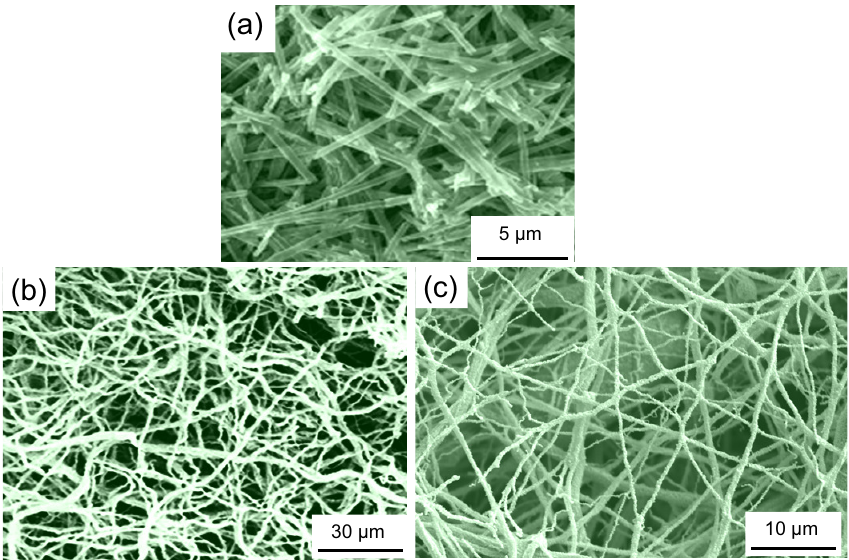
Figure 12. Comparison of HTSc nanowires fabricated using the AAO template approach (( a ), YBCO) [77] with such prepared by the electrospinning technique (( b ), Bi-2212) as measured in Ref. [95] and solution blow-spun nanowires (( c ), YBCO) [99]. Note the obvious difference in the length